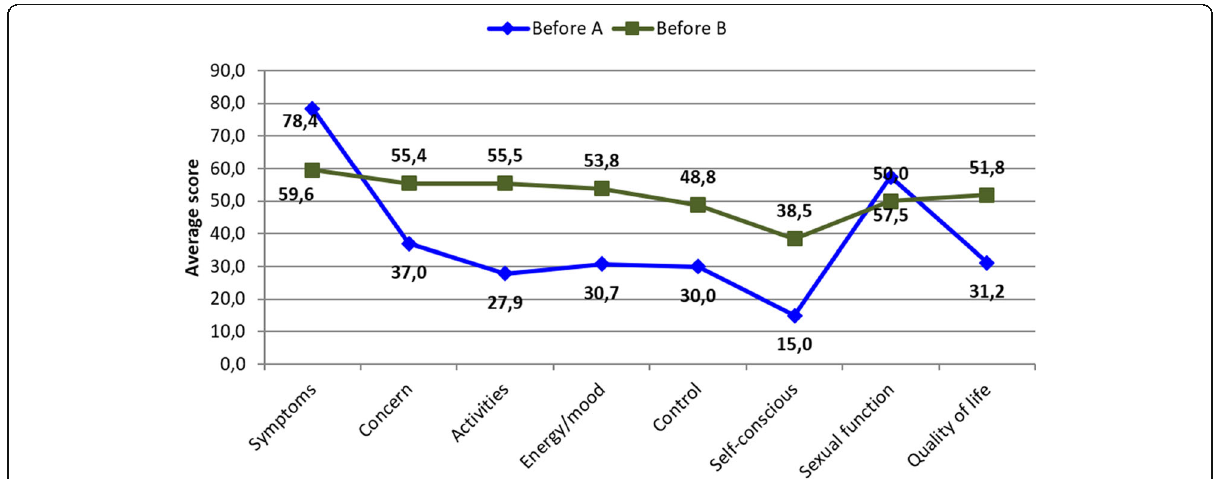
Fig. 5 Average score obtained in the UFS-QOL questionnaire, before UAE, referring to patients in group A (blue) and group B